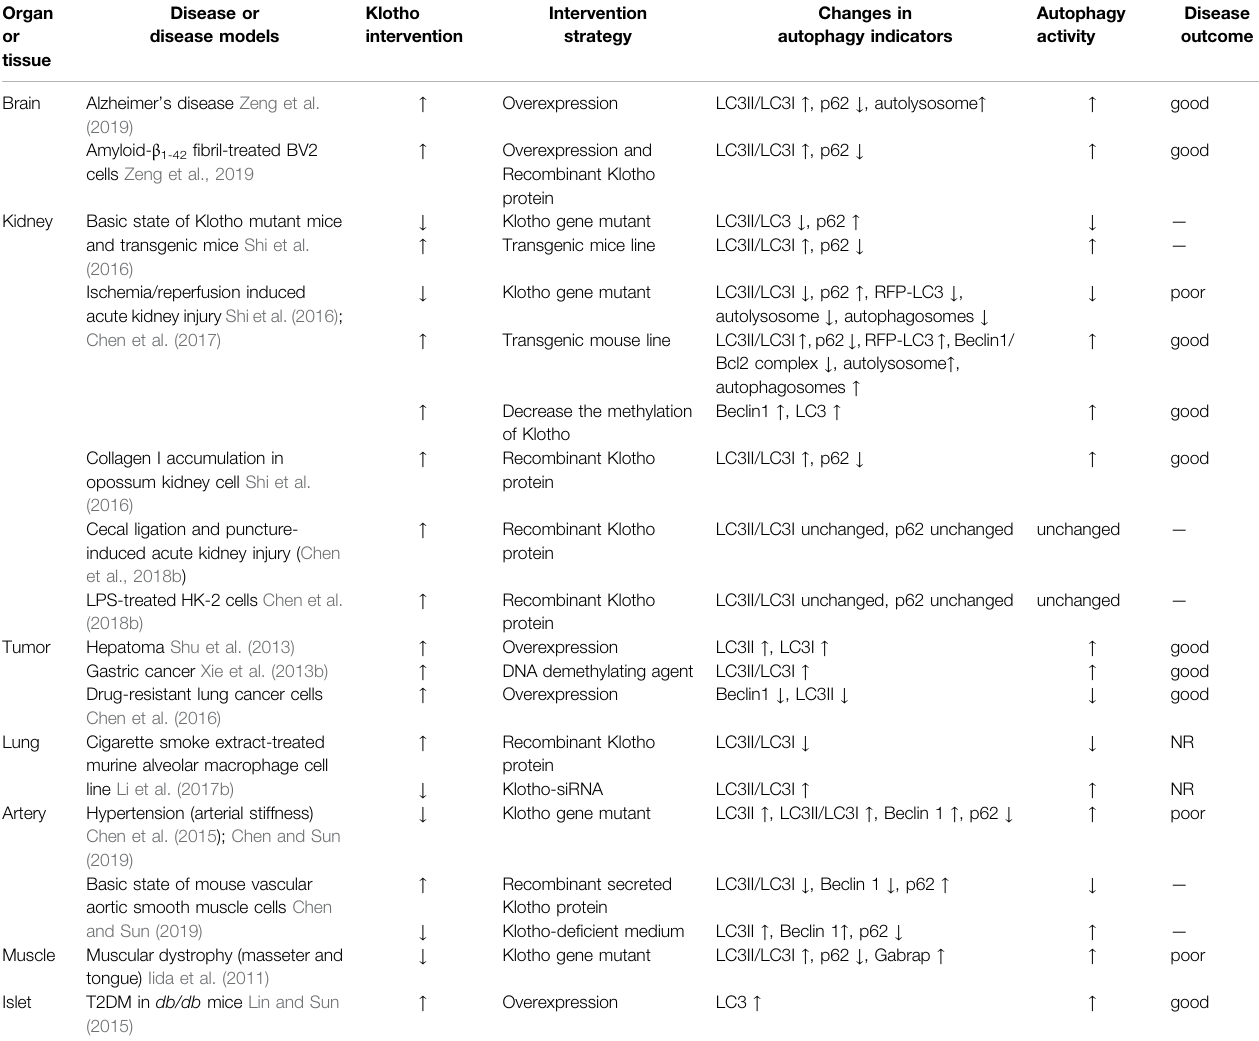
TABLE 2 | Regulatory effects of Klotho on autophagy in various diseases, as reported in interventional studies that manipulating Klotho expression. Organ or